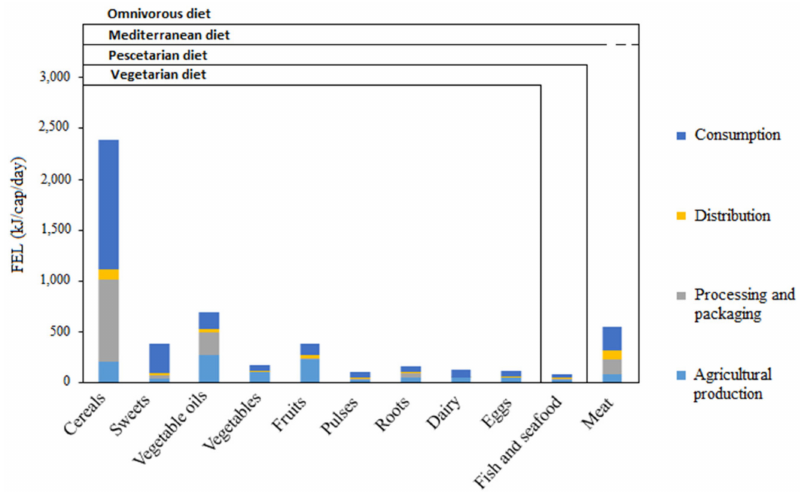
Figure 6. Food energy loss (FEL) of the different food categories throughout the supply chain. Values expressed in kilojoules per capita per